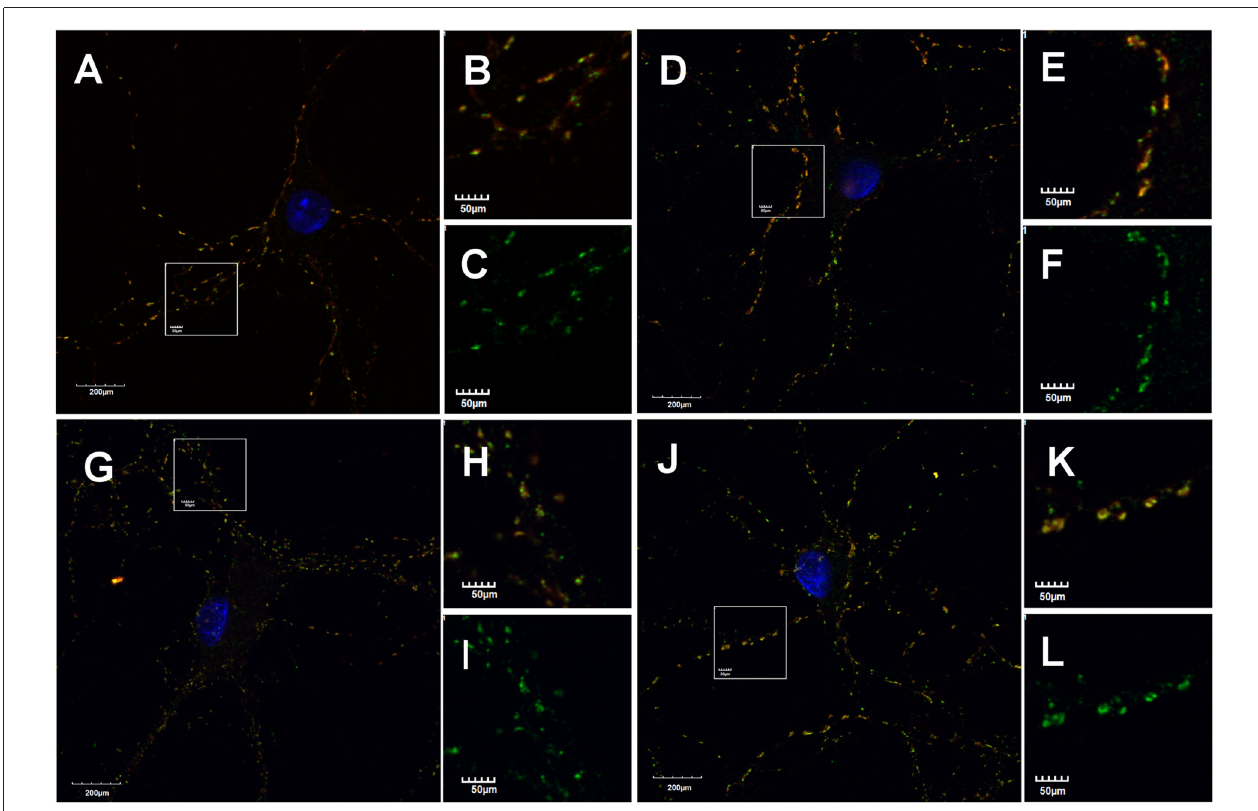
FIGURE 4 | Astrocytes affect morphology of gephyrin stained puncta. Supplementation of NC with astrocytes increase gephyrin (green) puncta size co-stained against vGAT (red) in NC and ANCC stimulated with NMDA. (A–C) Typical staining’s in NC, (D–F) typical staining in NC stimulated with NMDA, (G–I) typical staining in ANCC, (J–L) typical staining in ANCC stimulated with NMDA. Frame squares in (A,G,D,J) indicate the area shown at higher magnification on the right hand side of respective